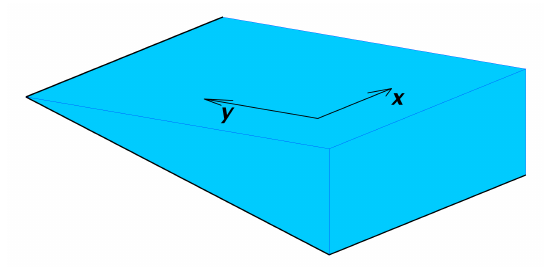
Figure 1. Model coordinate